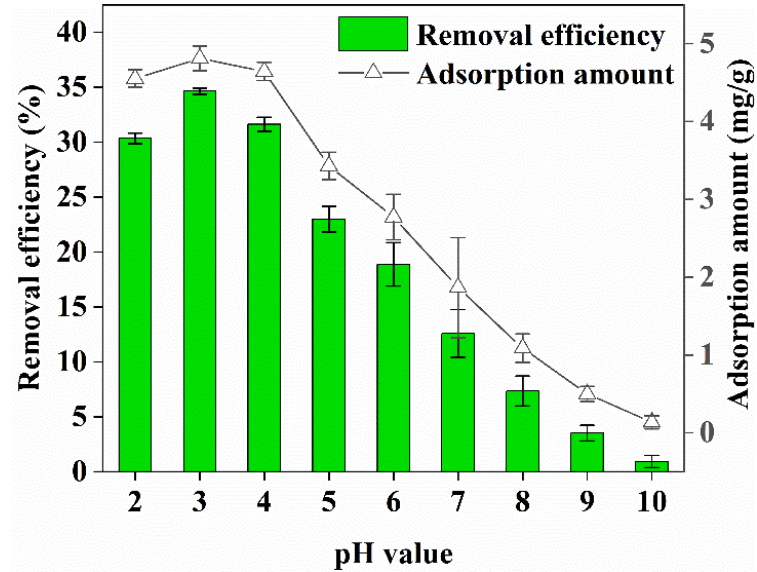
Figure 5. Effect of pH on Cr(VI)